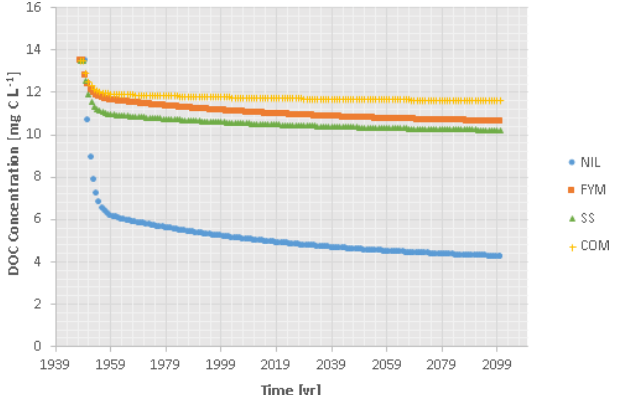
Figure 3. Estimated DOC concentration time trends in ZOFE top- soil (20cm) for the treatments NIL, FYM, SS and